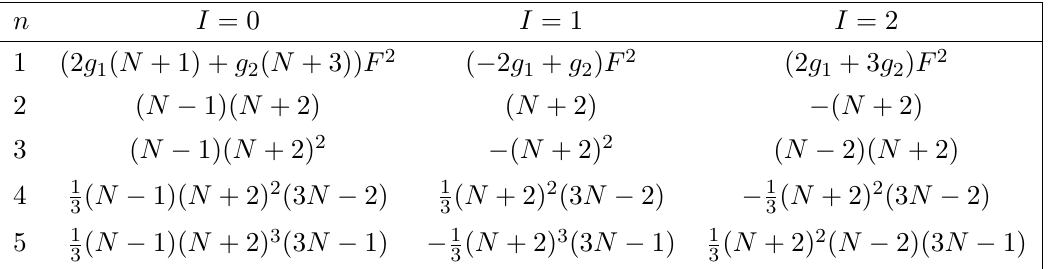
Table 1 . Table of I = 0 ; 1 ; 2 transmission LL-coe(cid:14)cients (multiplied by F 2 n ) for the bi-quartic model (1.6) up to four loops. Here 1 =F 2 = 2 g 1 + g 2 is the combination of coupling constants which enters the